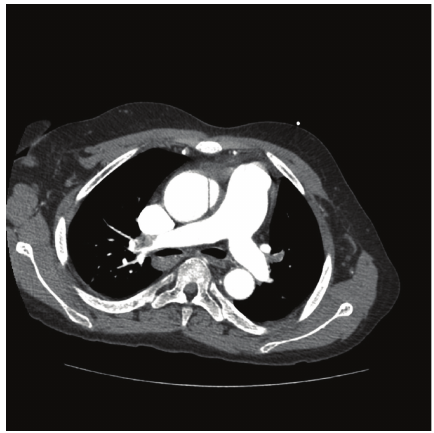
Figure 1: CT scan showing large filling defect in main pulmonary